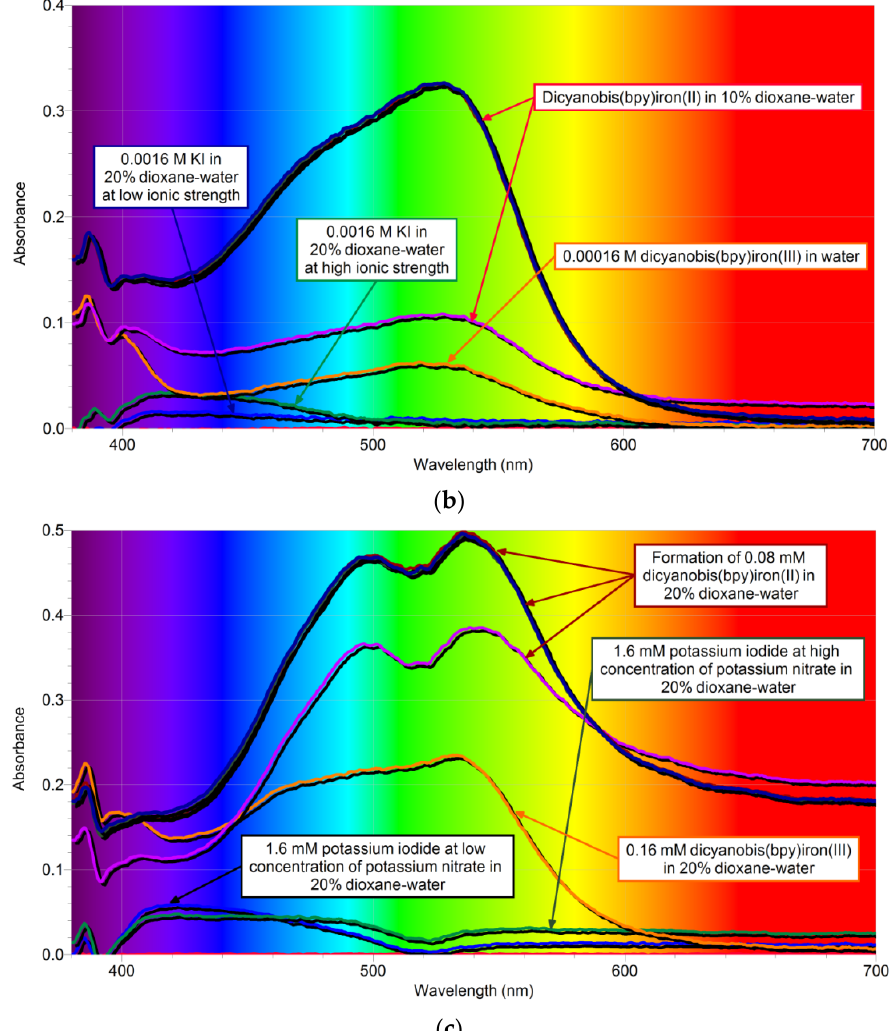
Figure 10. ( a ) Visible absorption spectra of reactants and product in water. ( b ) Visible absorption spectra of reactants and product in 10% v / v 1,4-dioxane-water. ( c ) Visible absorption spectra of reactants and product in 20% v / v 1,4-dioxane-water.